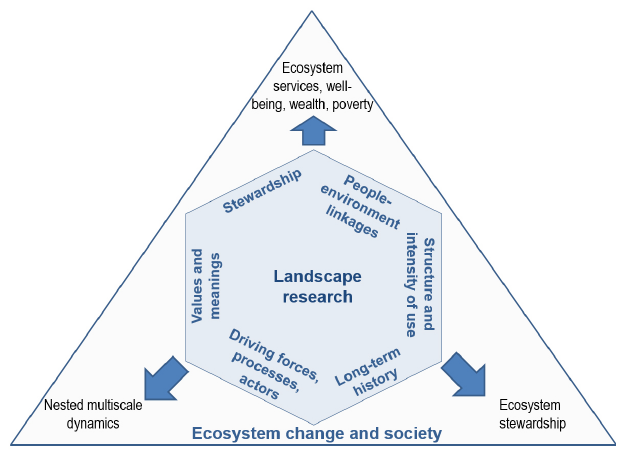
Fig. 1 . Schematic summary of six areas of recent progress in landscape research that can contribute to the three focal areas of ecosystem change and